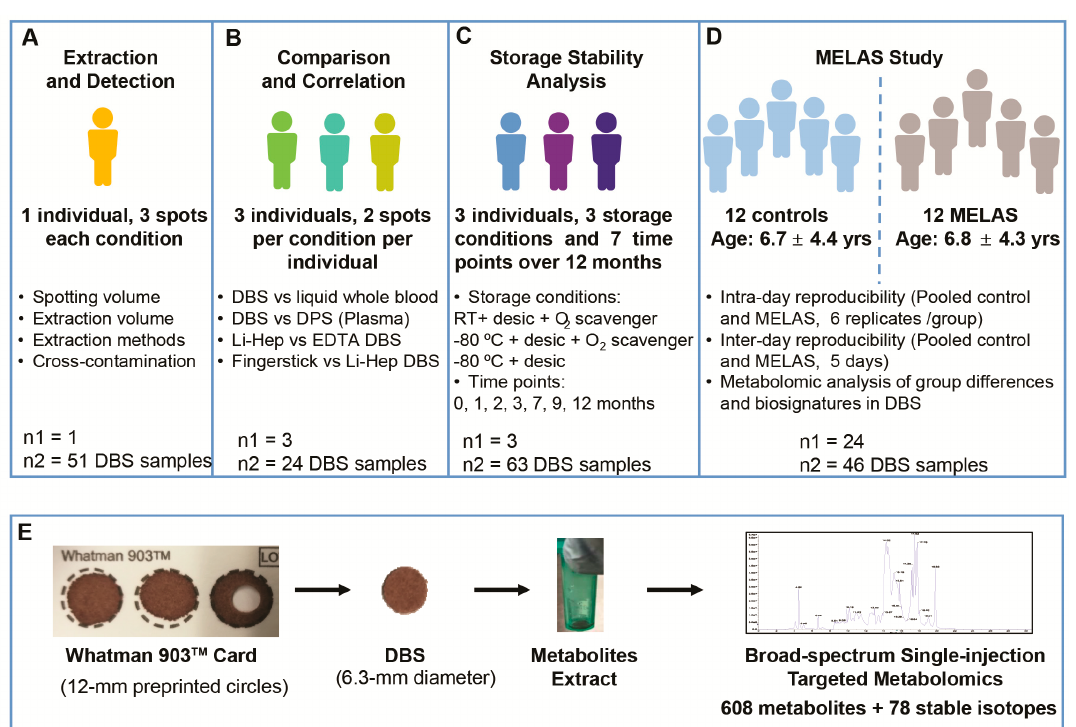
Figure 1. Overview of the study design and clinical cohorts. ( A ) Extraction and carryover. ( B ) Sample types. ( C ) Storage stability. ( D ) MELAS study. ( E ) DBS extraction and analysis.